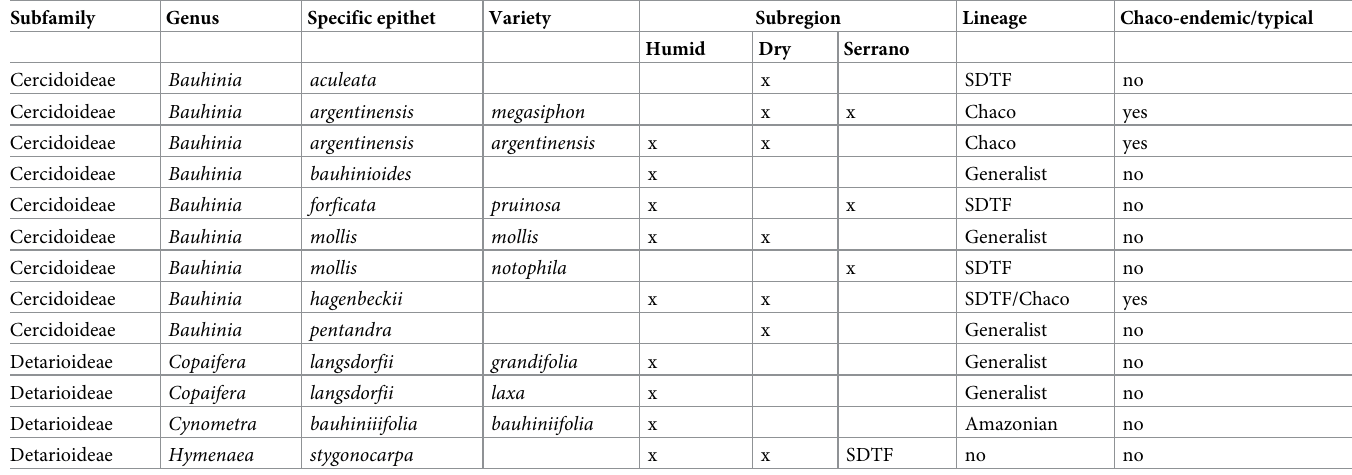
Table 3. Checklist of species and infraspecific taxa of Cercidoideae and Detarioideae subfamilies, their distribution in the Gran Chaco, lineage and